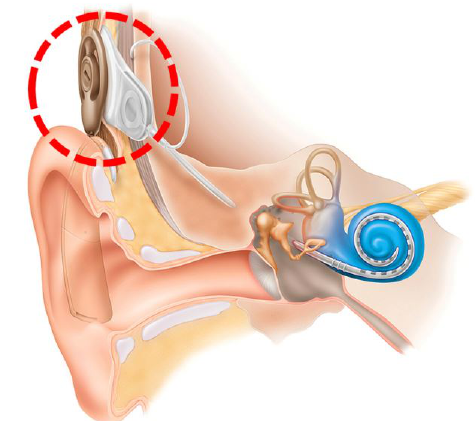
Figure 5. Illustration of cochlear implant (with a red dotted line) for a patient’s ears